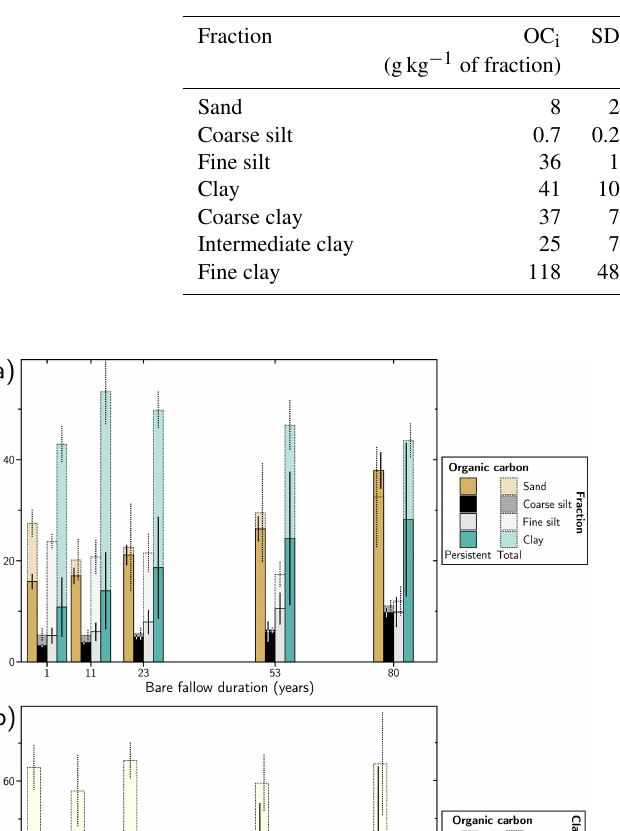
Table 3. Parameters of the exponential decay function (OC( t ) = OC i · e − with duration of the long-term bare-fallow experiment for the different size fractions considered (OC i : intermediate organic carbon, MRT: mean-residence time, OC p : persistent organic carbon). The standard deviation (SD) obtained for each parameter is given in the next column to the right.